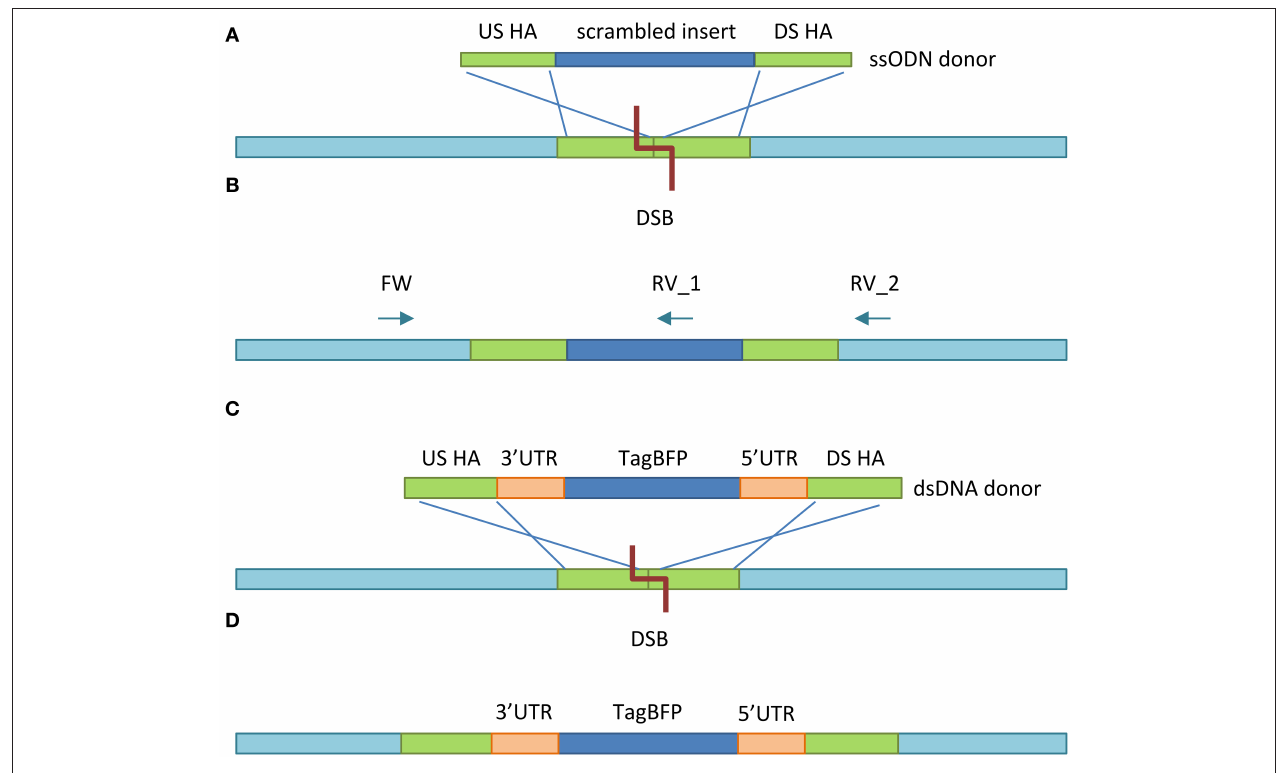
FIGURE 2 | Experimental design. (A) After Cas12a introduces the DSB at the target site, HDR takes place between the US HA and DS HA of the ssODN donor template and the homologous regions US and DS from the DSB. (B) The insert is incorporated between the US and DS homologous region. Two PCR reactions determine whether mutation was successful: (1) reverse primer 1 (RV_1) anneals inside of the insert, yielding a product of 910 bp, providing HDR took place. (2) Reverse primer 2 (RV_2) anneals to the wild type gene sequence, yielding a 1,025 bp (wild type) or 1,127 (mutant) product. Both reactions use the same forward (FW) primer. (C) As with the ssODN donor, the US and DS HA recombine with their homologous regions US and DS of the DSB made by Cas12a. (D) The TagBFP gene with 5 ′ and 3 ′ UTRs of the S. domuncula actin locus is inserted into the genome in reverse orientation.